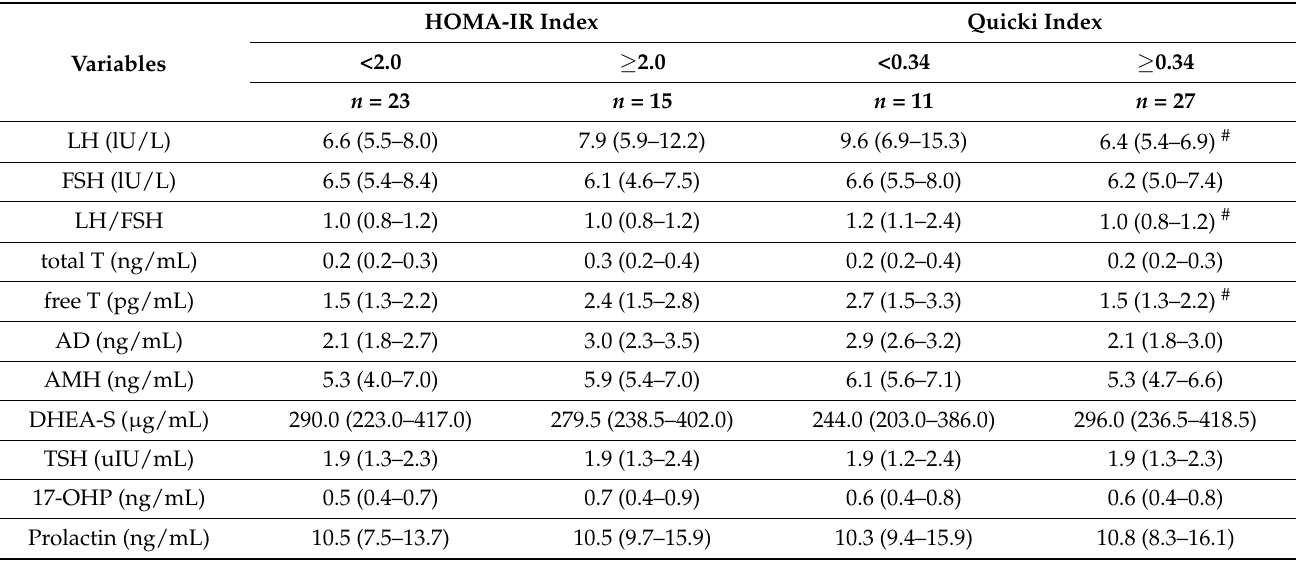
Table 4. Hormone status in the studied groups divided according to HOMA-IR and Quicki